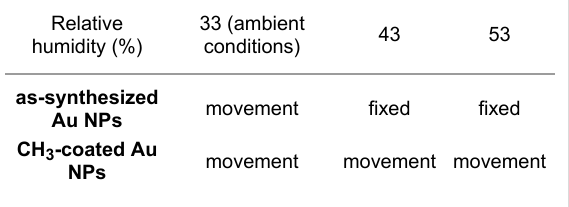
Table 1: Mobilities of spherical Au nanoparticles (hydrophilic and hydrophobic) versus humidity rate during their manipulation using an AFM in tapping mode (zigzag scan